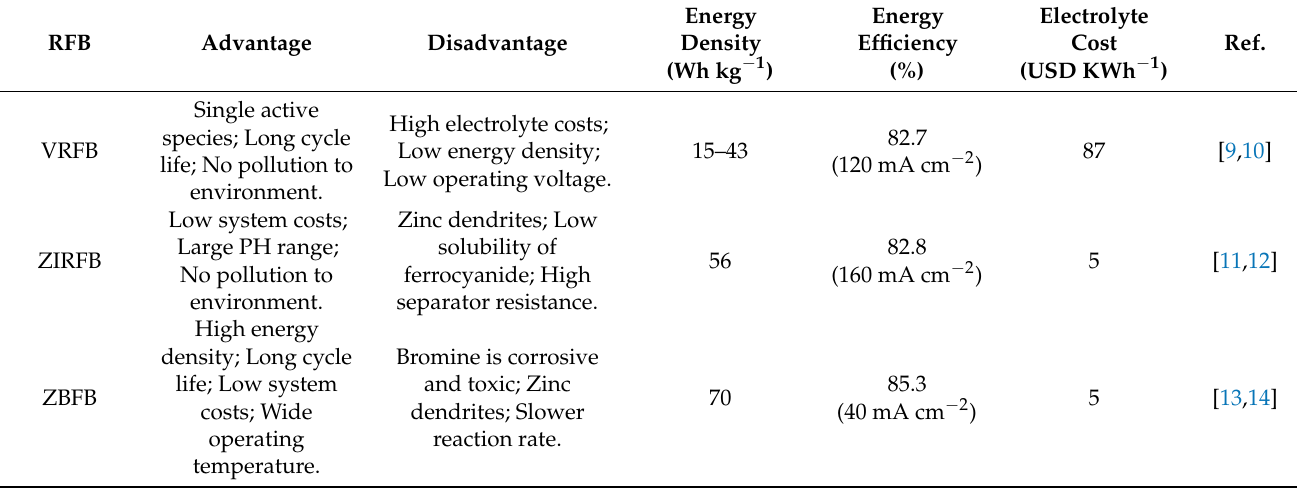
Table 1. Comparison of the advantages and disadvantages of VRFB, ZIRFB, and